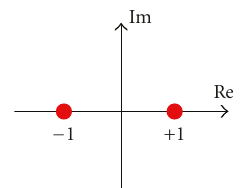
Figure 1: Lag coe ffi cients taken on the real